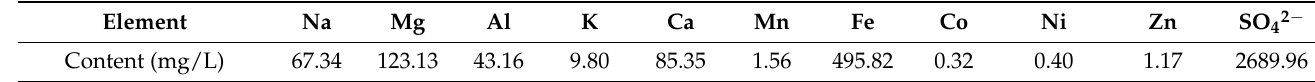
Table 4. Compositions of real AMD.